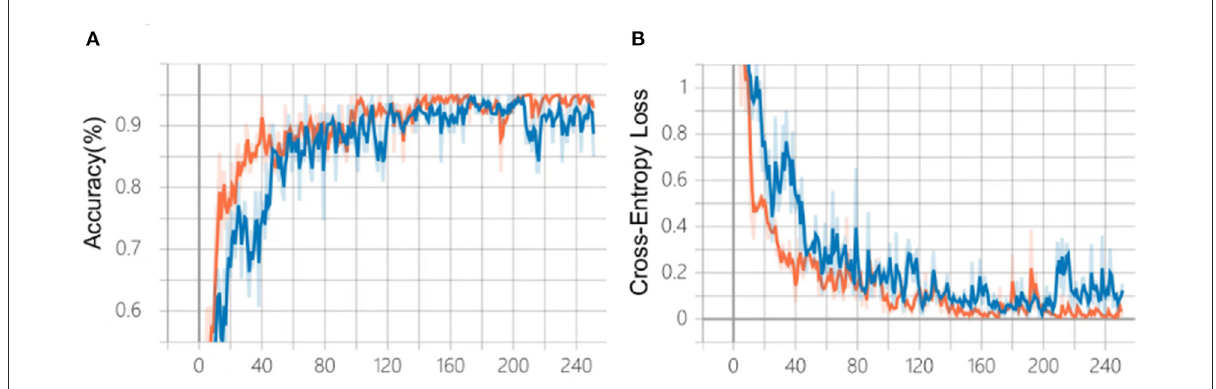
FIGURE4 Comparison of the training process of the two algorithms. (A) Changes in accuracy during training. (B) Changes of cross-entropy in training. Blue line: algorithm A; Orange line: algorithm B.